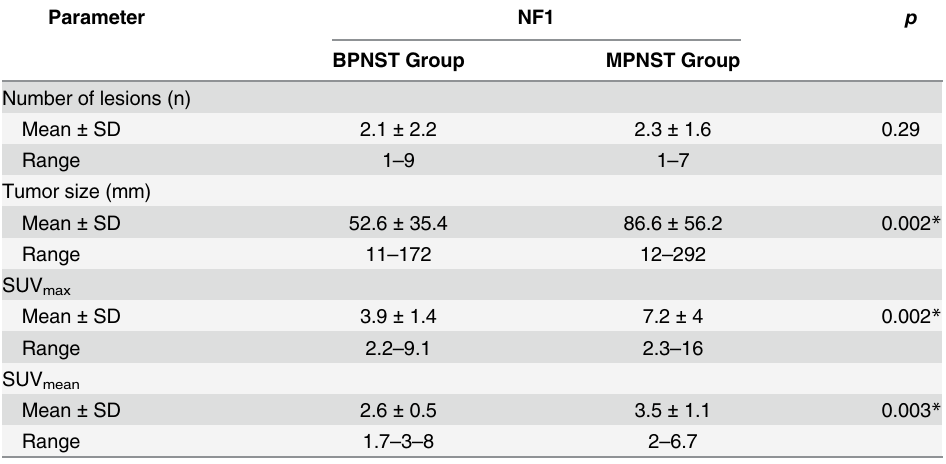
Table 4. Data on imaging-derived parameters comparing the patient group with benign PNST only and the group with benign and malignant PNSTs at a threshold of 2.0. Parameter NF1 p BPNST Group MPNST